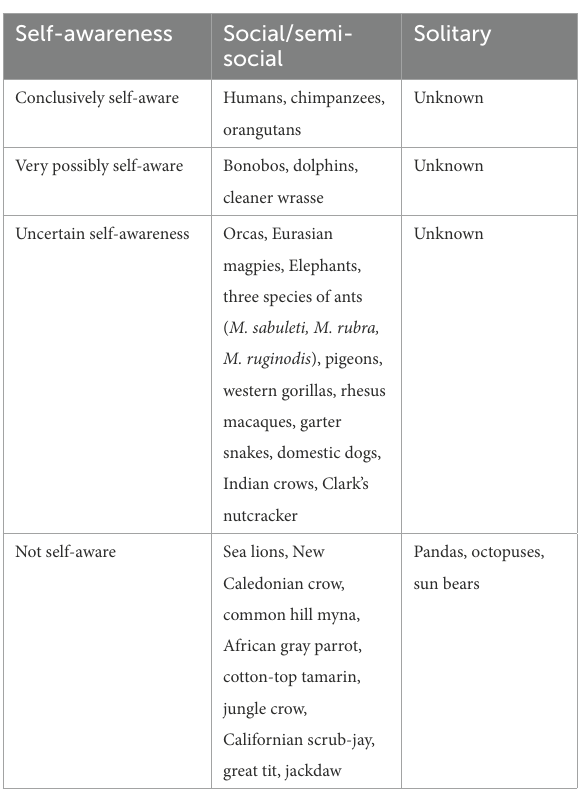
TABLE 1 Summary of social and solitary animals by their self-